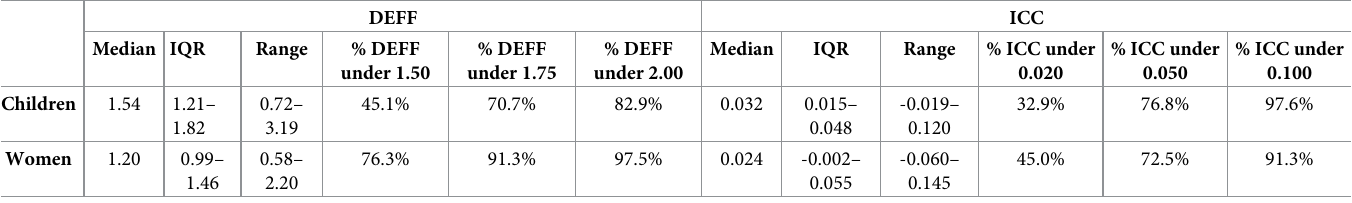
Table 3. Distribution of anemia design effects and intracluster correlation coefficients for women and young